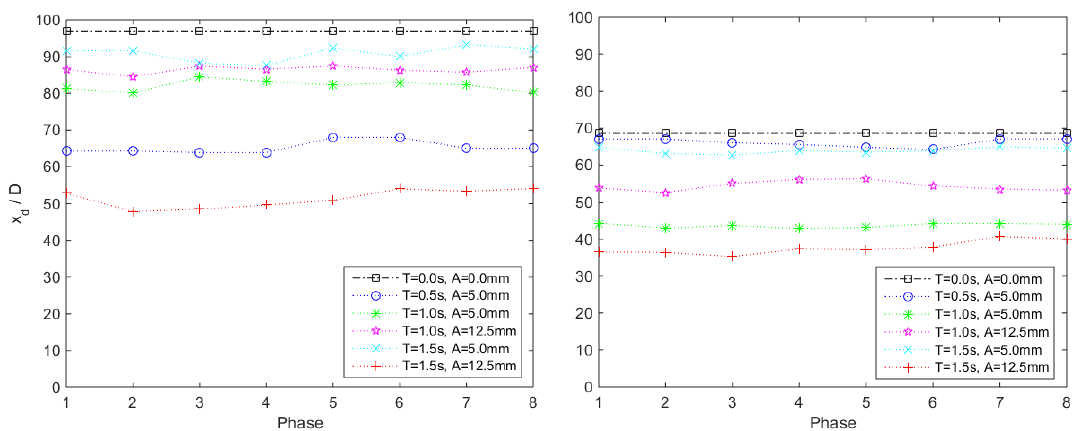
Figure 8. Non-dimensional impact distance x d /D for the NBJs with Fr = 28.0 ( left ) and Fr = 18.0 ( right ) released into a receiving body affected by regular waves (wave parameters in the legend).